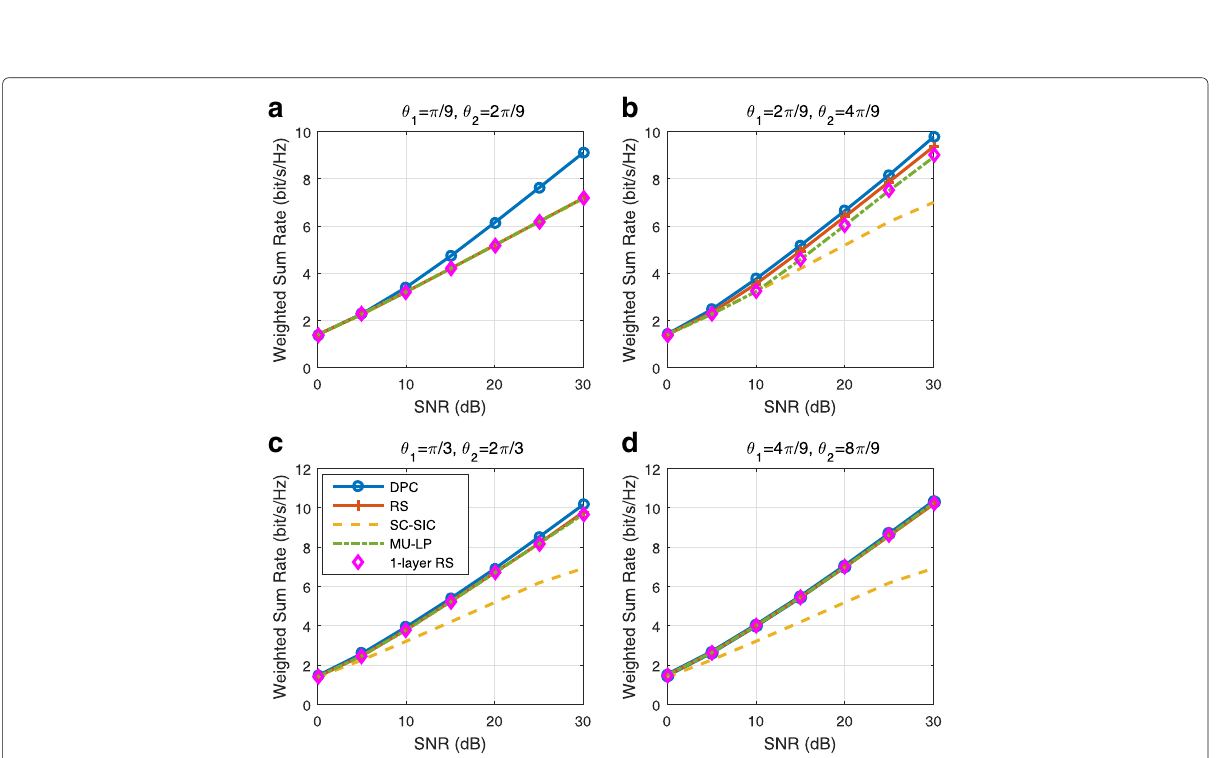
Fig.35 Weighted sum rate versus SNR comparison of different strategies for underloaded three-user deployment with perfect CSIT, γ 1 = 1, γ 2 =